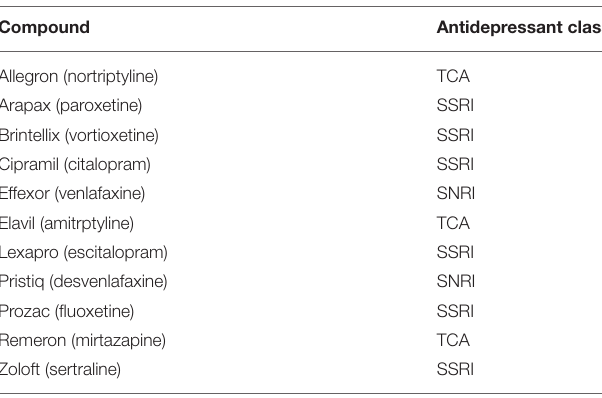
TABLE 1 | List of antidepressants participants were receiving at least two months prior to trial commencement.